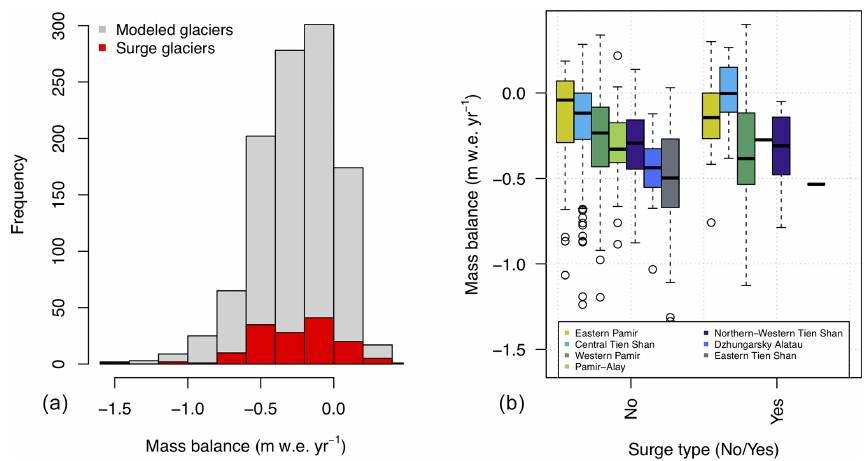
Figure A5. Distribution of surge-type glaciers and mass balance range (a) of all glaciers and (b) for the HIMAP regions. The regional comparison shows that no systematic difference was found between the relationship of surge- and nonsurge-type glaciers with mass balance.